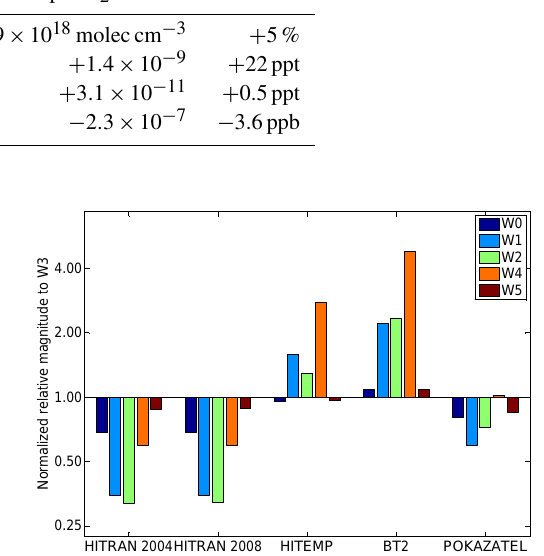
Figure 11. Comparison of different available water vapour cross section data in the blue spectral range, using different bands listed in Fig. 6. W3 was used as a respective reference in all cases and is therefore by definition unity. All magnitudes were normalised with respect to the rescaled HITEMP absorption cross section from Lampel et al. (2015b) to obtain relative magnitudes of each of the absorption bands W0, W1, W2, W4 and W5. A value of unity iden- tifies good agreement with the relative magnitude of the absorp- tion bands’ sizes according to MAX-DOAS and LP-DOAS mea- surements presented in Lampel et al.